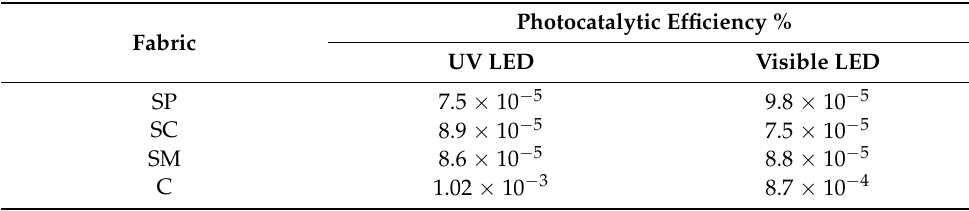
Table 8. TOF parameter calculated at time 100 min. Tests carried out with TACR at T ◦ = 25 ◦ C, under both UV and visible light sources.